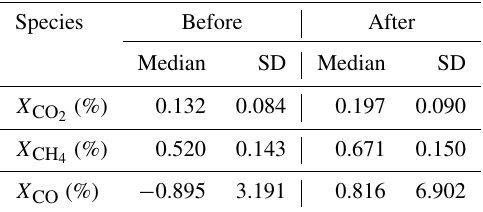
Table 1. TCCON–COCCON comparison statistics (median and standard deviation) before and after the EM27/SUN deployment to Arrival